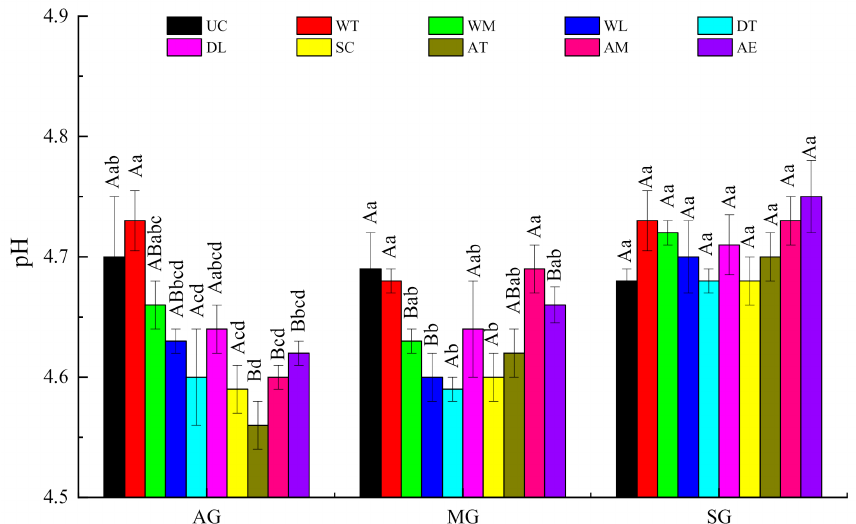
Figure 7. The pH in the different spatial positions in different stages of Benggang restoration.